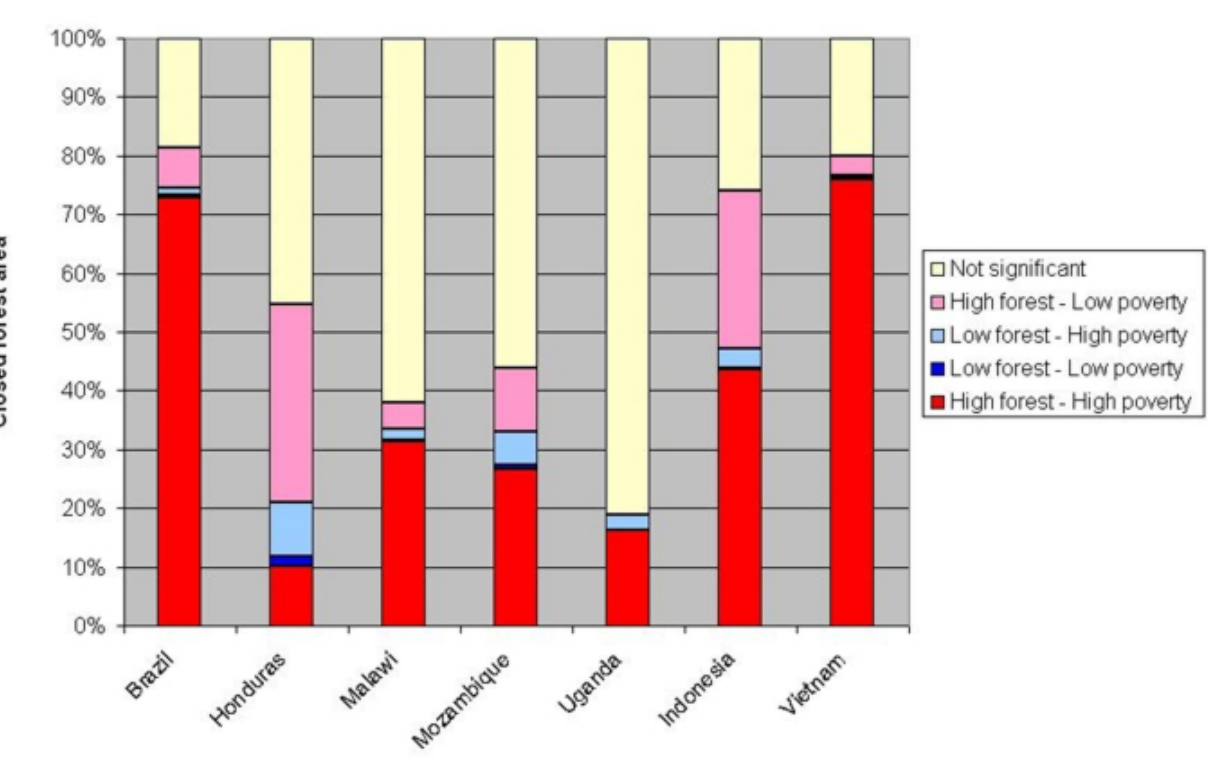
Fig. 8. Distribution of local indicators of spatial association forest vs. poverty rate findings by percentage of closed forest